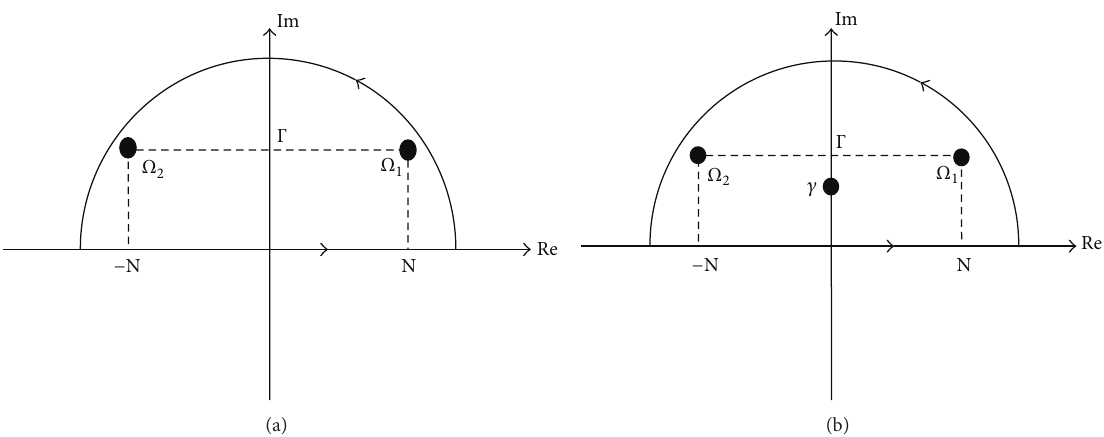
Figure 2: Contours of integration and position of poles in the complex plane. (a) Dirac pulse. (b) Exponentially decaying step